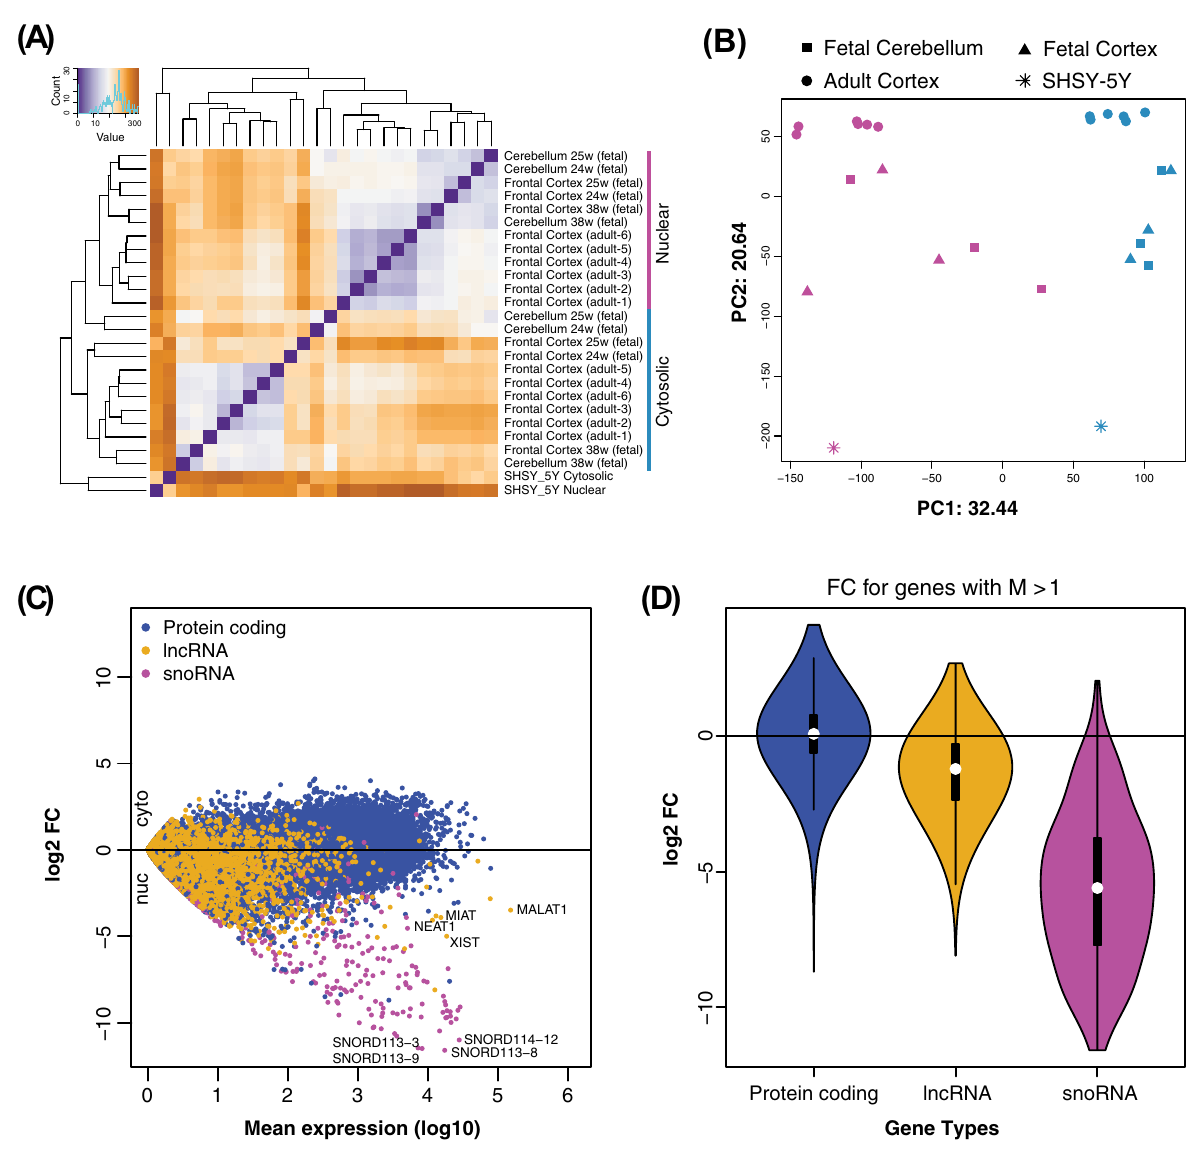
Figure 1. Characterization of the cytosol and nuclear transcriptomes. (A) Hierarchical clustering analysis of cerebellum (fetal), frontal cortex (fetal and adult) and SHSY-5 cytosolic and nuclear samples using DESeq2 rlog-normalized counts. The Euclidean distance values used for clustering are represented by a color code from brown (low correlation) to purple (maximum correlation). (B) Principal component analysis performed using the same rlog-normalized expression data. Contribution to variance for principal components, PC1 and PC2, are reported in the graph. (C) Expression means versus log 2 fold changes (log 2 FC) showing global (all tissues) cytosolic and nuclear expression differences for protein-coding, lncRNA and snoRNA genes. Each point with log 2 FC > 0 corresponds to cytosolic localization whereas log 2 FC < 0 corresponds to nuclear localization of the genes. (D) Violin plot of gene biotypes in (C) displays log 2 FC (y-axis) distribution between cytosolic and nuclear fractions in all brain samples combined. White dots indicate mean, box edges represent the interquartile range, and the colored region and curve show the probability density function. Each group is composed of genes with log 10 mean expression higher than one (M > 1), and shown in similar colors as in (A)